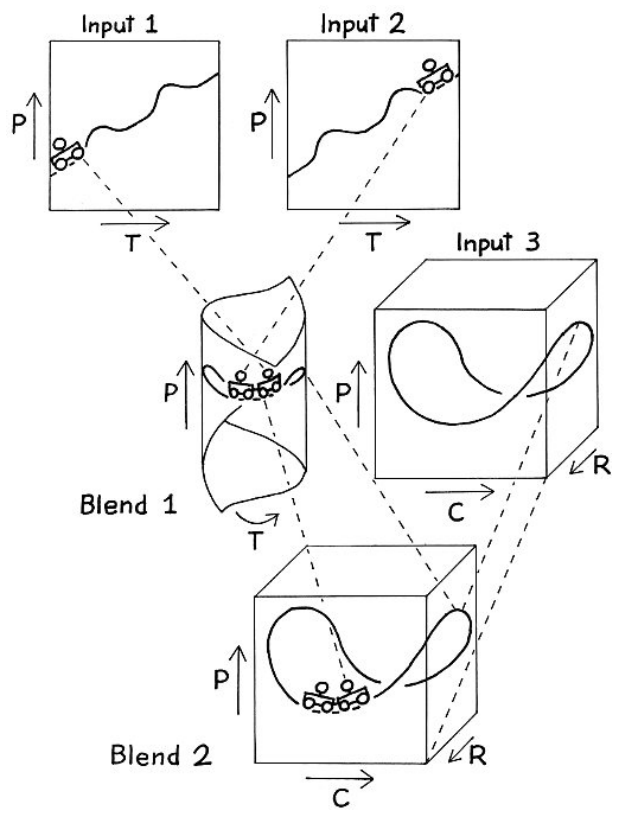
Fig. 3 . Conceptual blending of neoclassical economics and adaptive cycle theory. T = time, P = potential, C = connectedness, R =